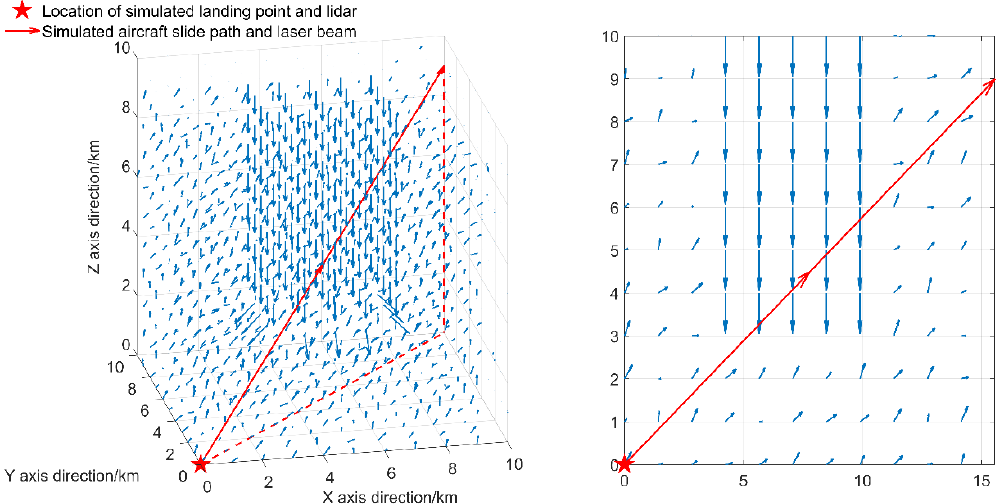
Figure 8. The left figure is the simulated downdraft wind field in the 3-D coordinate system; the right figure is the profile view of the simulated downdraft wind field.